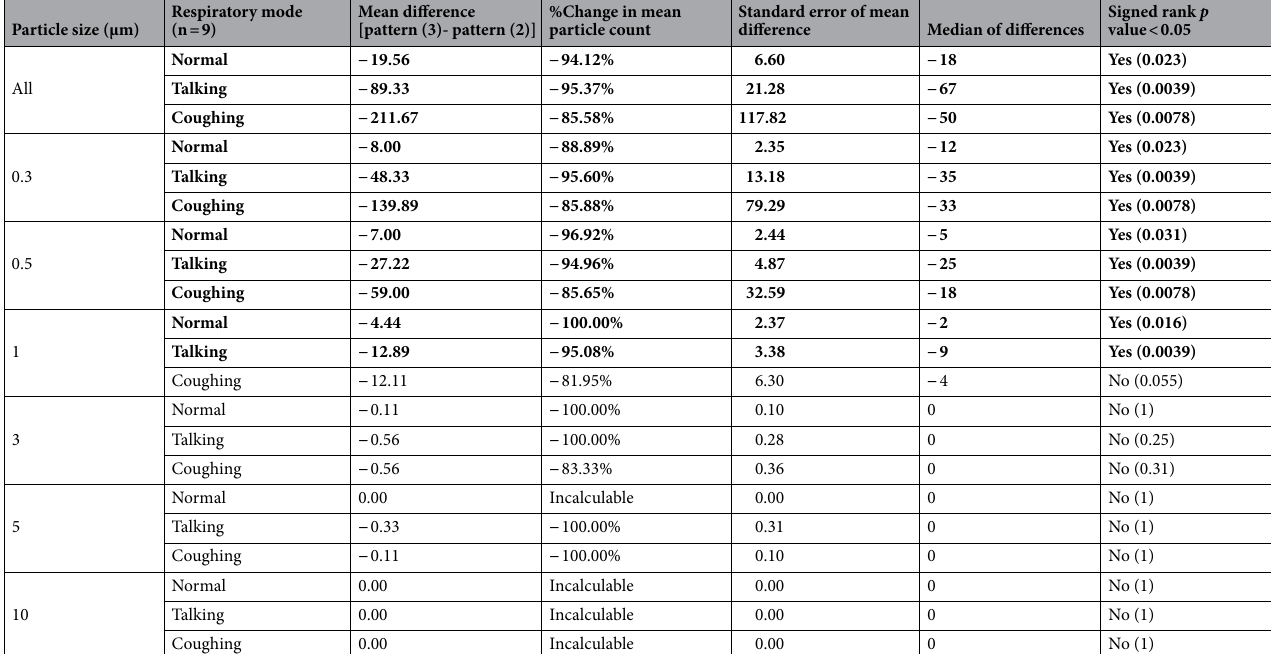
Table 2. Differences in particle counts by particle size and respiratory mode between experiment patterns 2 and 3. Bold rows highlight the scenarios in which significant differences were